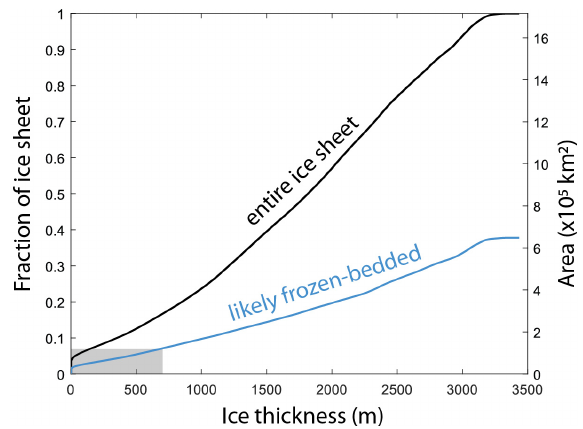
Figure 2. Greenland Ice Sheet thickness versus area. Plot shows that only about one-third of the ice sheet by area is likely frozen-bedded and thus available for subglacial access. The current limit of drills operating under 700m ice thickness further reduces available por- tion of the ice-sheet bed for access (gray area). Note that increasing a drill’s depth capability increases the area of the bed available for drilling; the ability to drill into wet-based sections of the ice sheet would significantly increase the area available for